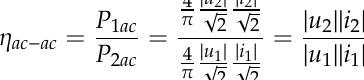
Table 1. Measured experimental data.